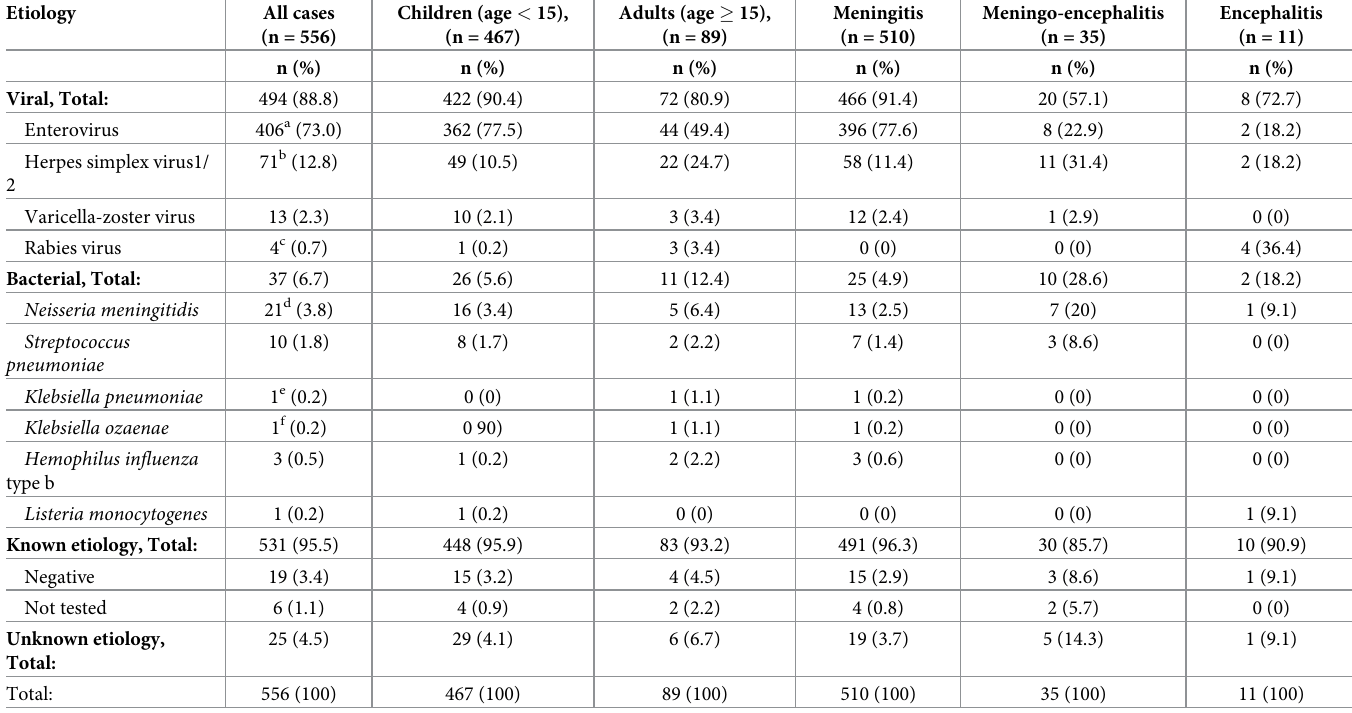
Each patient is only included in a case count once.